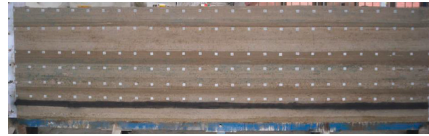
Figure 2: The image of the whole